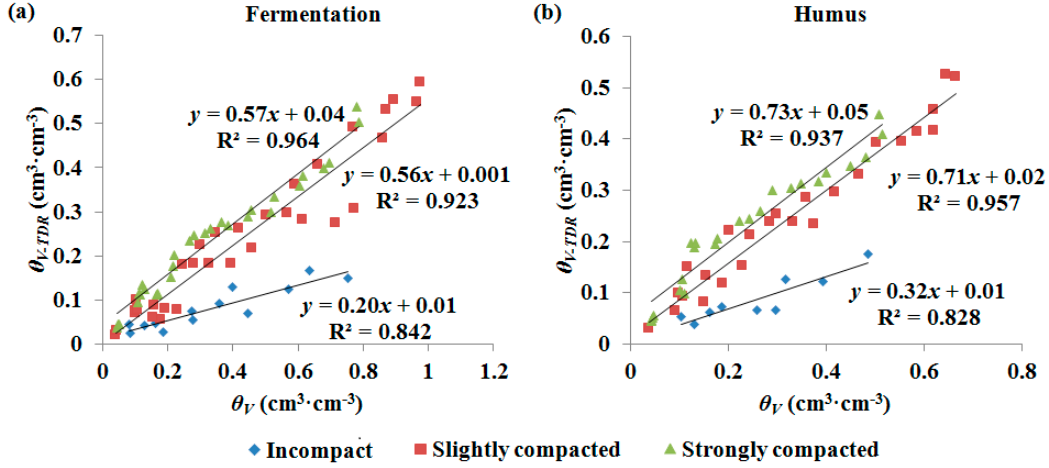
Figure 6. Volumetric water content determined gravimetrically ( θ V ) vs. TDR measured volumetric water content ( θ V-TDR ) for the samples of fermentation ( a ) and humus ( b ) in different compaction classes.